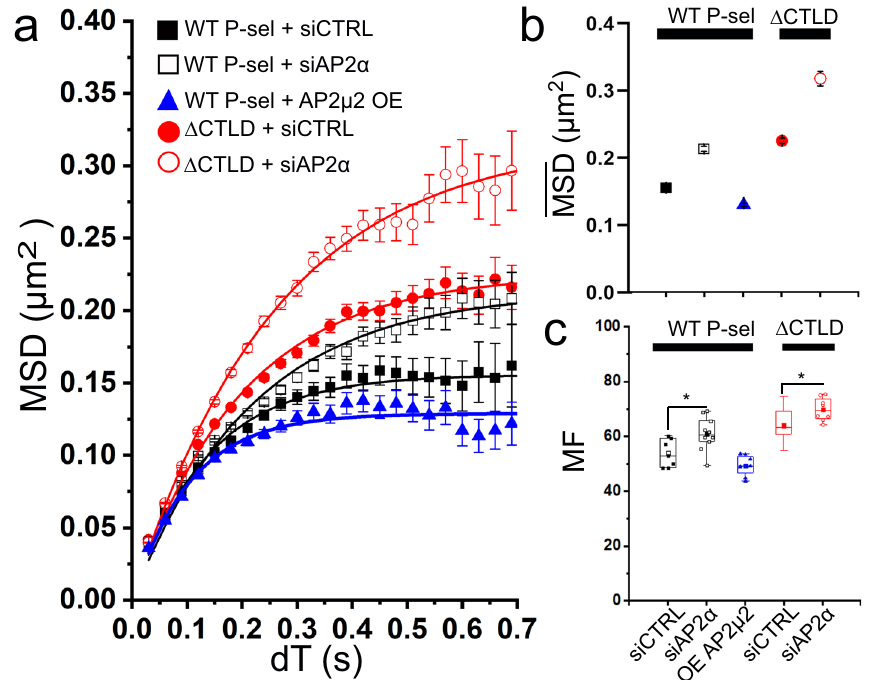
Fig. 5 At steady-state P-selectin-CT shapes mobility via AP2. a MSD vs dT plots show: WT siControl (solid back squares; 5056 SMs, n = 7 cells, two experiments) compared to WT with siAP2 α treatment (open black squares; 9307 SMs, n = 14 cells, two experiments) and WT with AP2 µ 2-mcherry overexpression ( “ OE ” ) (solid blue triangles; 5629 SMs, n = 7 cells, two experiments). The effect of siAP2 α treatment on Δ CTLD mobility (open Red circles; 8300 SMs n = 17 cells, two experiments) is compared with Δ CTLD siControl (solid red circles; 19,391 SMs, n = 18 cells, two experiments). Data were collected under steady-state conditions. Data points are means, error bars ± s.e.m., solid lines are non-linear least-squares fi ts Eq. 1. b Limiting amplitude for diffusion (MSD) ( fi t value ±95% con fi dence intervals) and c the MF plotted as Box and Whiskers as de fi ned in Fig. 1. Results of one-way ANOVA, multiple comparisons, and Tukey test, indicated as: “ * ” P =